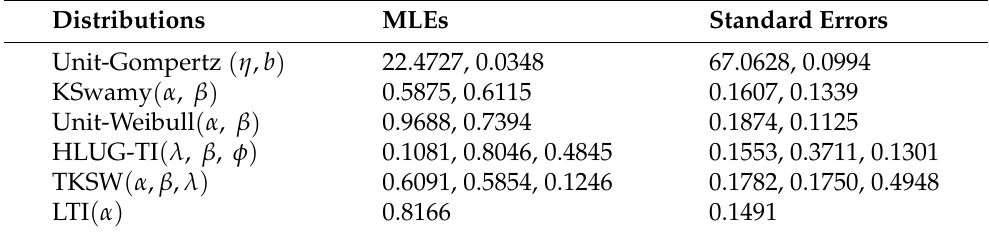
Table 2. MLEs and SEs of the parameters of considered distribution for Data Set I.